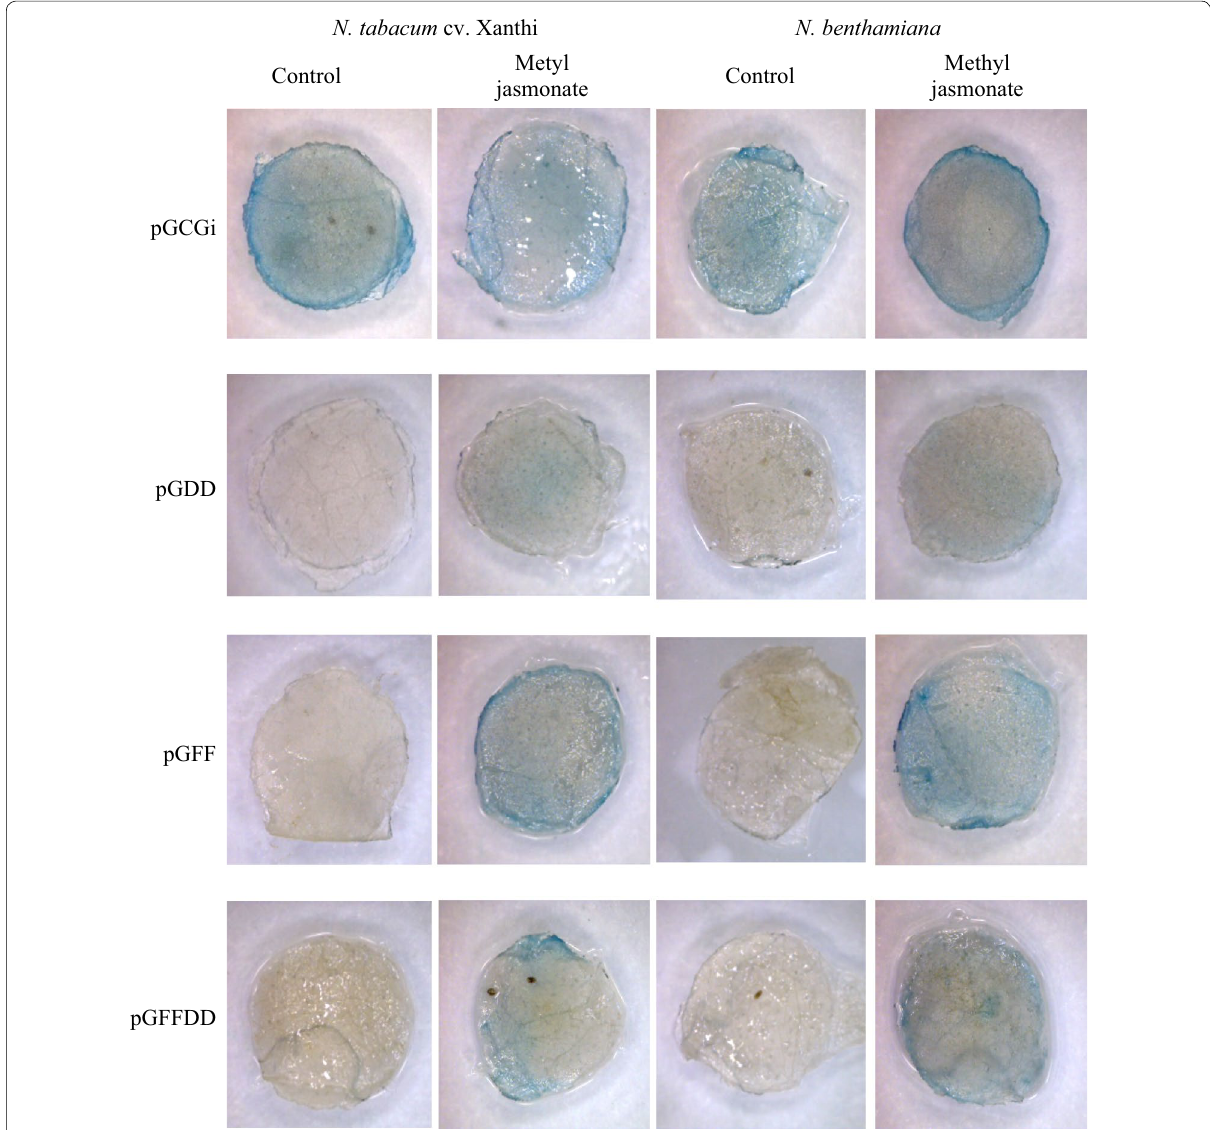
Fig. 5 Effect of methyl jasmonate treatment on pGCGi, pGDD, pGFF and pGFFDD constructs evaluated on two tobacco species; N. tabacum cv. Xanthi and N. benthamiana . Agro-injected plants without methyl jasmonate treatment were used as control (More replications have